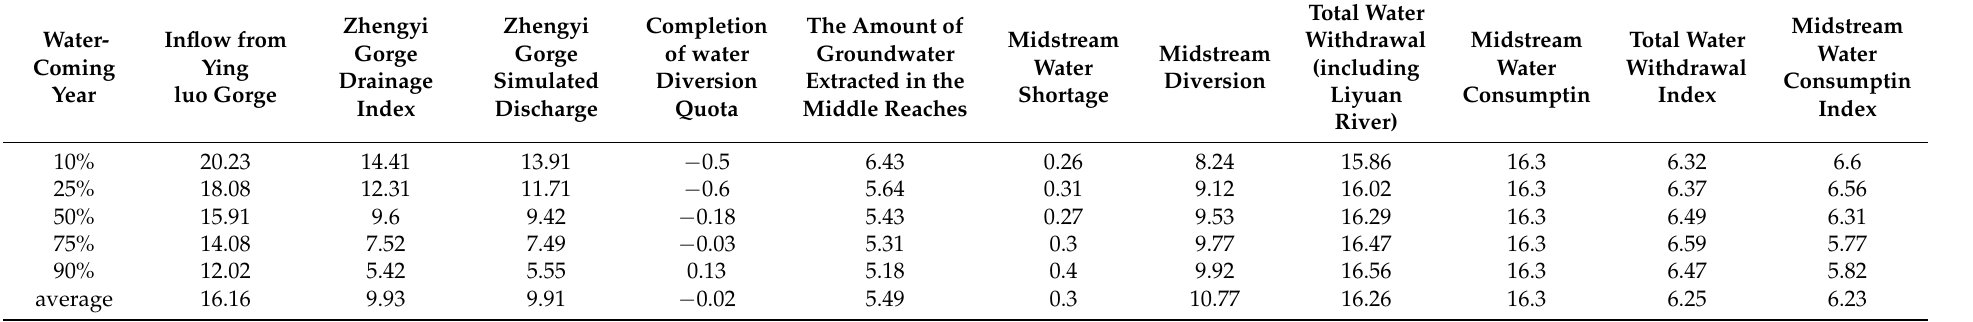
Table 9. The results of mid-stream water resources allocation under the condition of strong water-saving, 10 8 m 3.